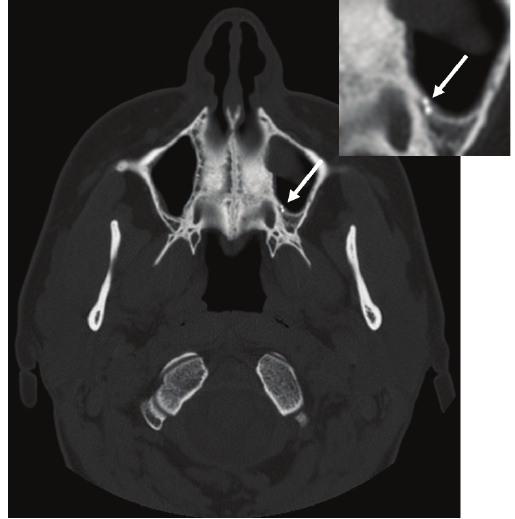
Figure 3. Axial section of non-contrasted CT scan shows two retained remnants of gutta-percha (white arrow) in the left posterior maxillary sinus. Inset in the top-right corner reveals a zoomed image of the two gutta-percha remnants.